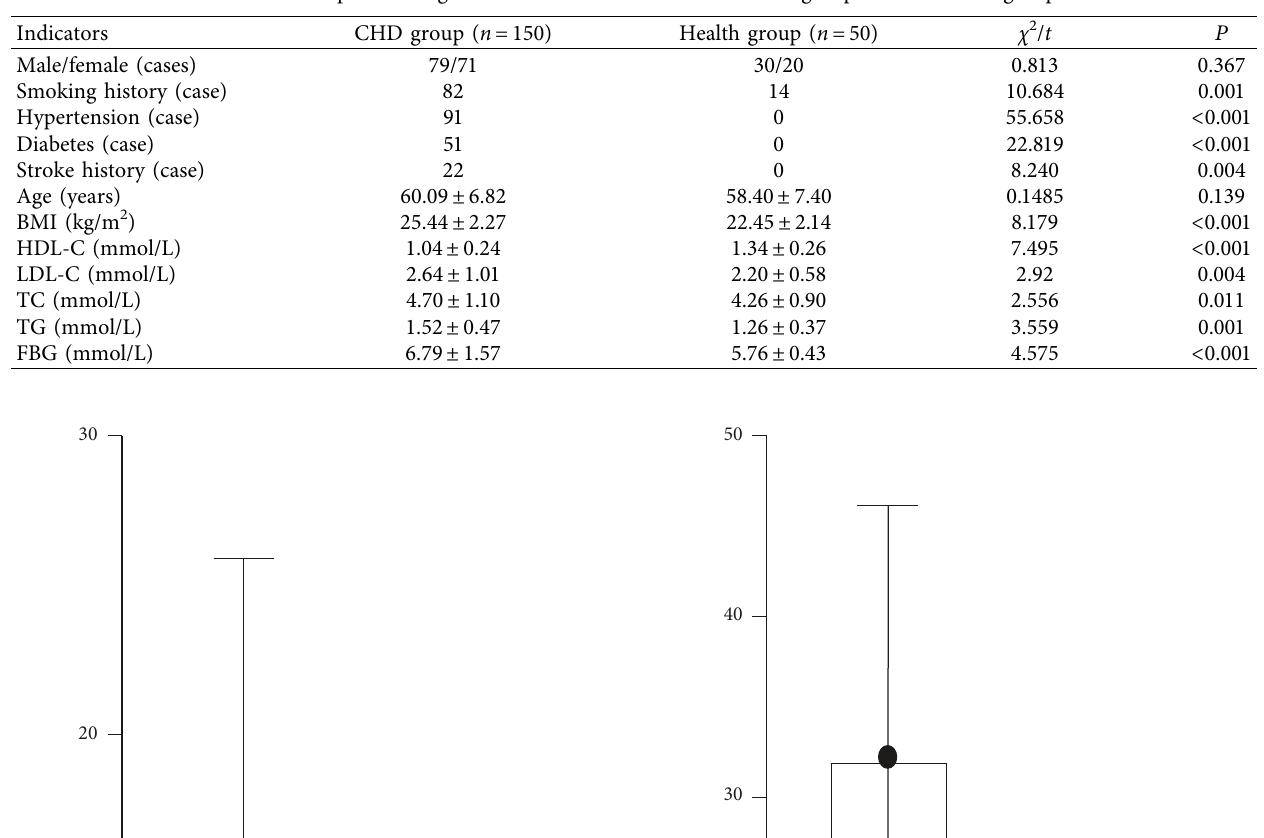
Table 1: Comparison of general information between the CHD group and the health